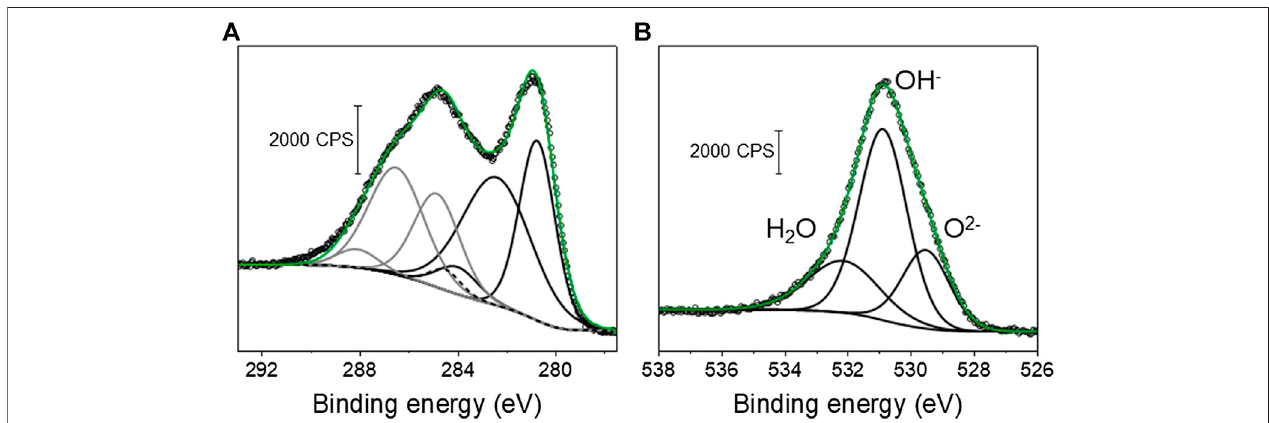
FIGURE 5 | (A) XPS Ru 3d core level spectrum of C-RuO 2 . The XPS signal components represented with black lines are Ru 3d 5/2 orbitals and the components